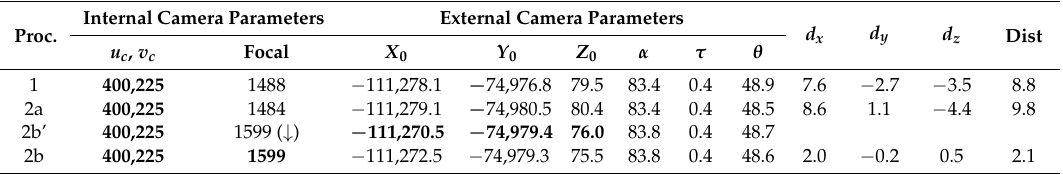
Table 3. Camera parameters results. Parameters set fixed during the iterative process are written in bold. Displacement to the remotely-derived camera location are is shown along the three relative dimensions ( d x , d y , d z ) and in term of Euclidean distance (dist). Proc.